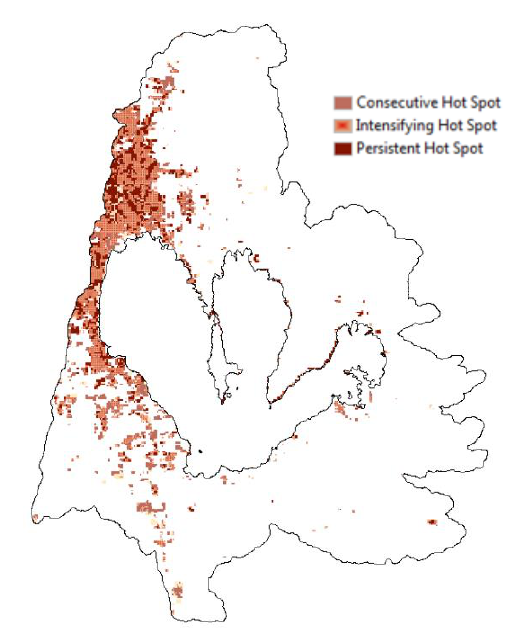
Figure 5. Vegetation hot spot map of Laguna Lake